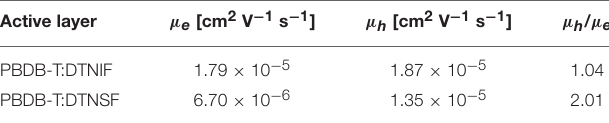
TABLE 3 | Hole and electron mobilities of the SCLC devices based on two different active layers. Active